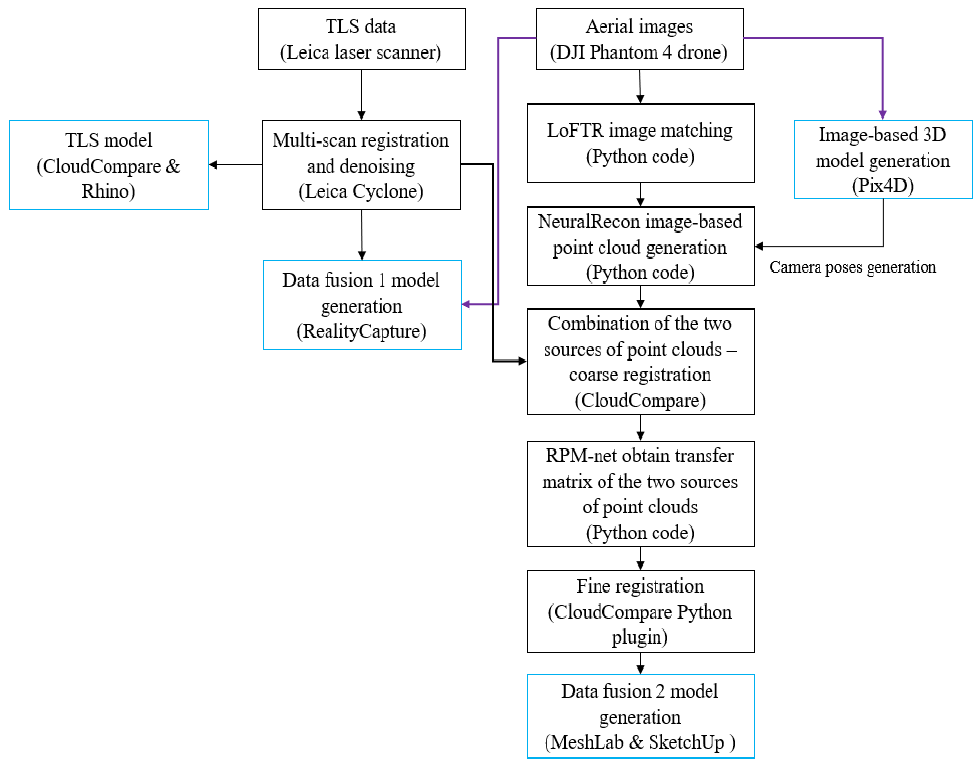
Figure 15. The generation process and software used for the four models: image-based model, TLS model, data fusion 1 model (using common method), and data fusion 2 model (using the proposed method).